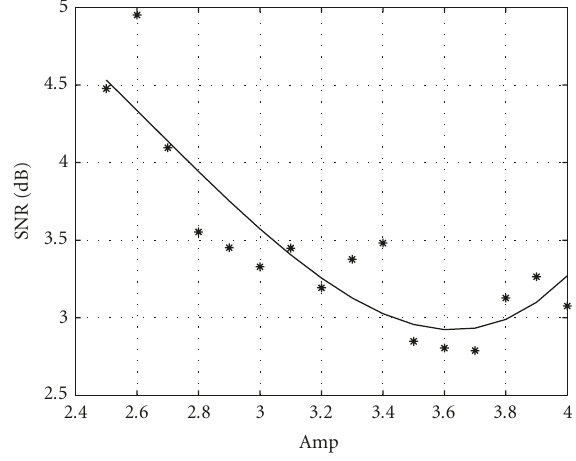
Figure 8: SNR @ BER = 0.0001 versus Amp (rate = 0 . 42, A = 0 . 1, GIR = 0 .